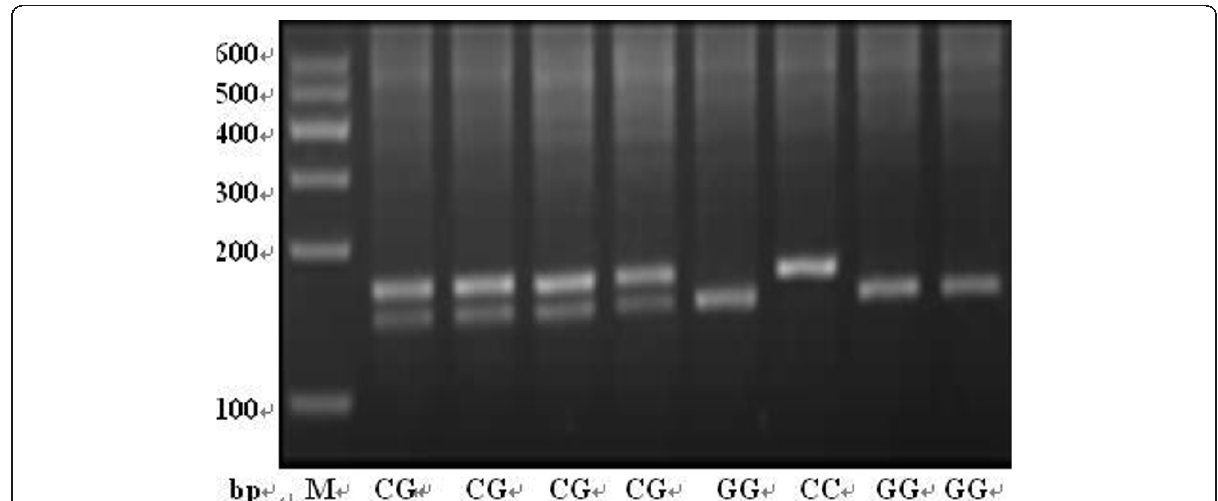
Figure 1 The genotypes of rs8073069 by PCR-RFLP